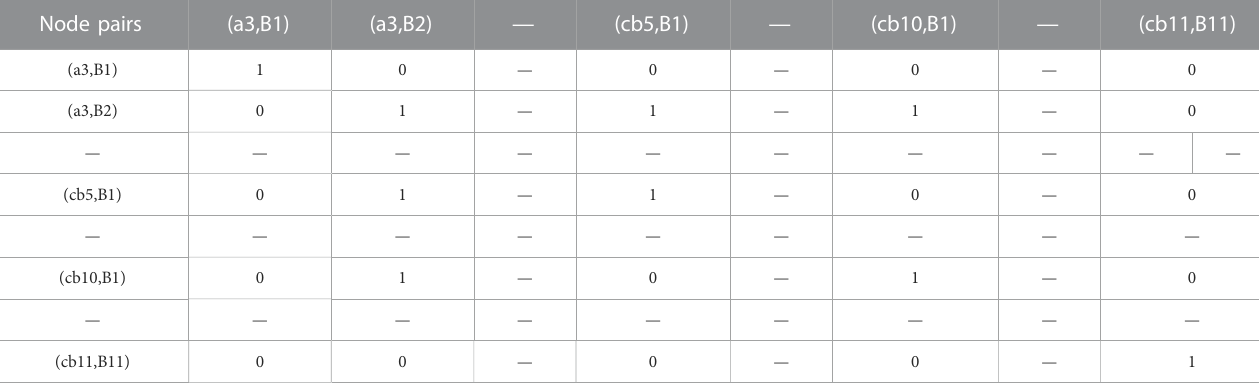
TABLE 3 Improved adjacency matrix. Node